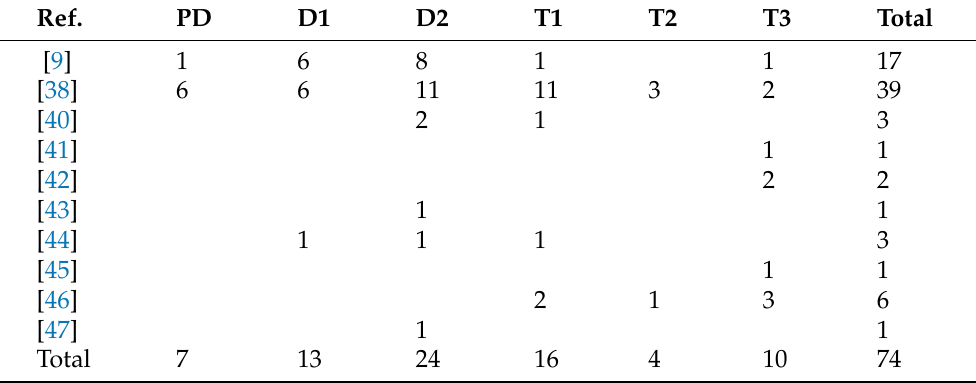
Table 2. The distribution of the 74 testing samples according to the fault types and the references.